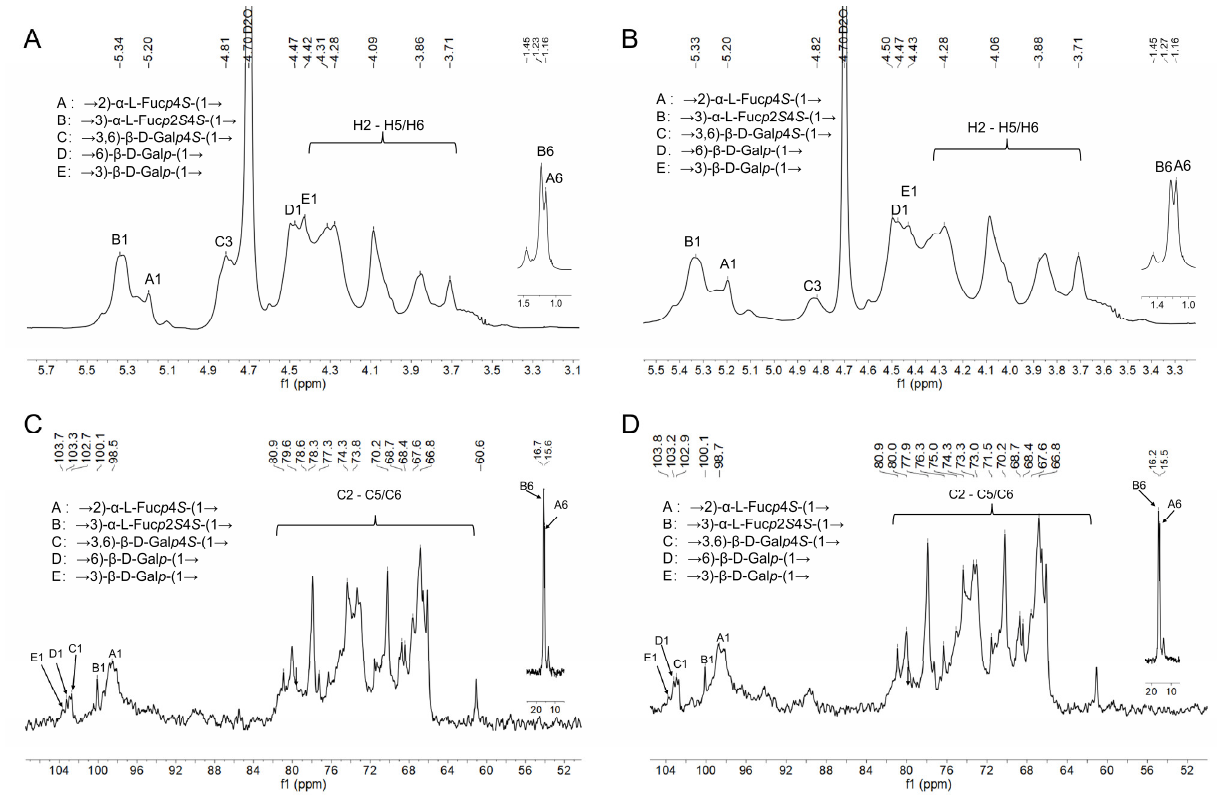
Figure 2. 1 H NMR spectra of ANP-6 ( A ) and ANP-7 ( B ) and 13 C NMR spectra of ANP-6 ( C ) and ANP-7 ( D ).